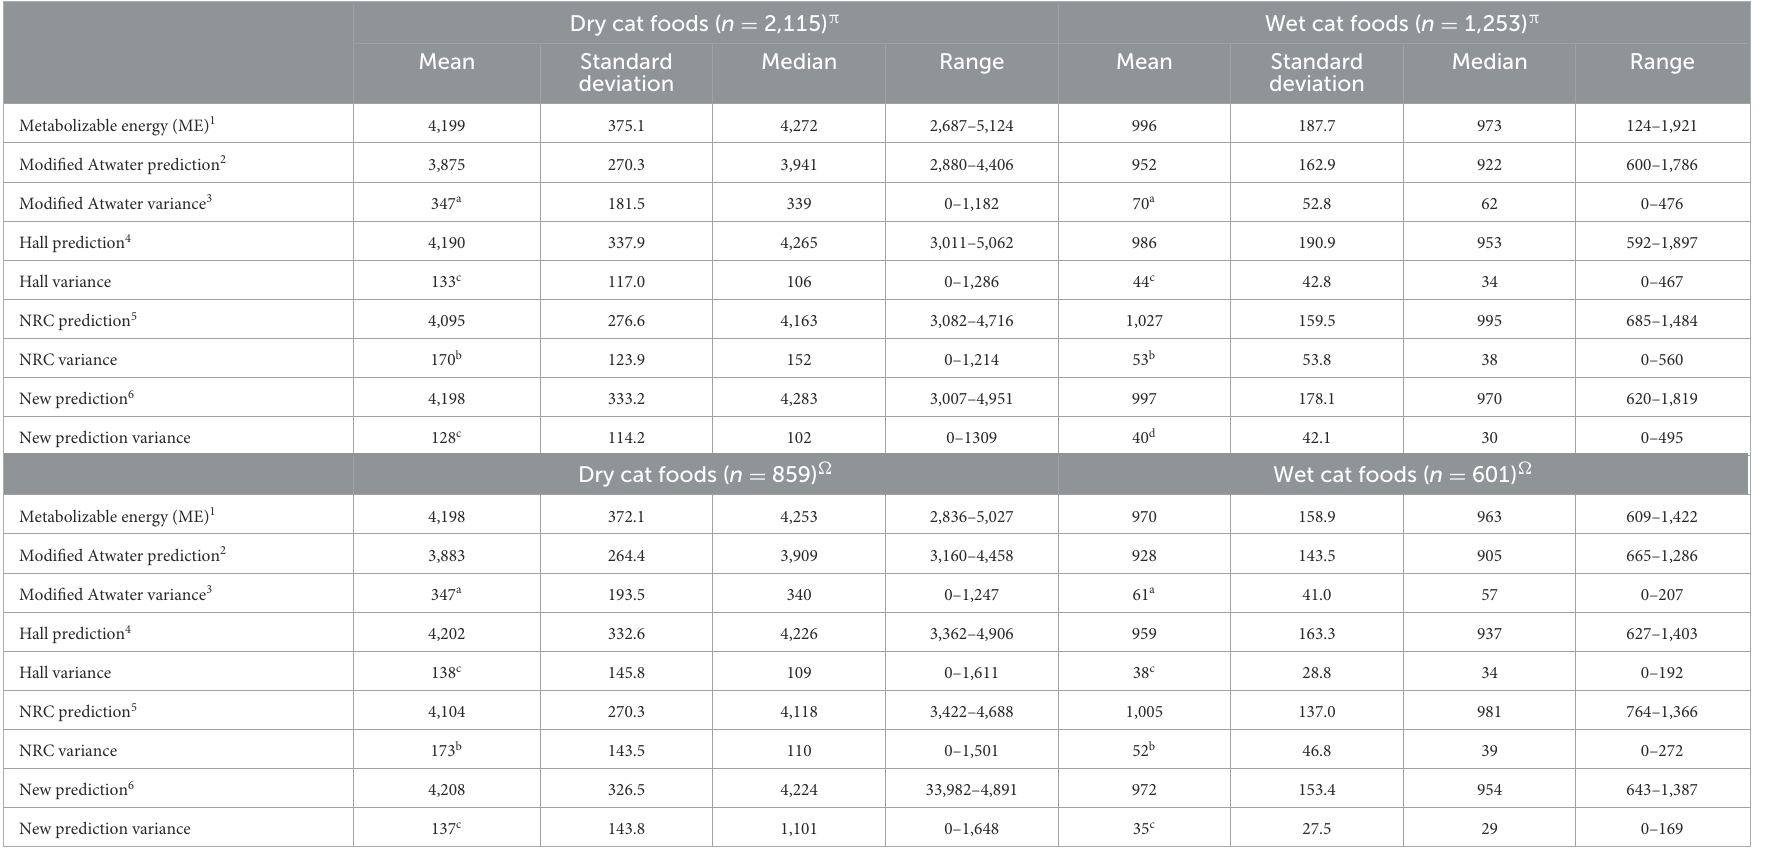
TABLE 4 Feline tested and estimated metabolizable energy